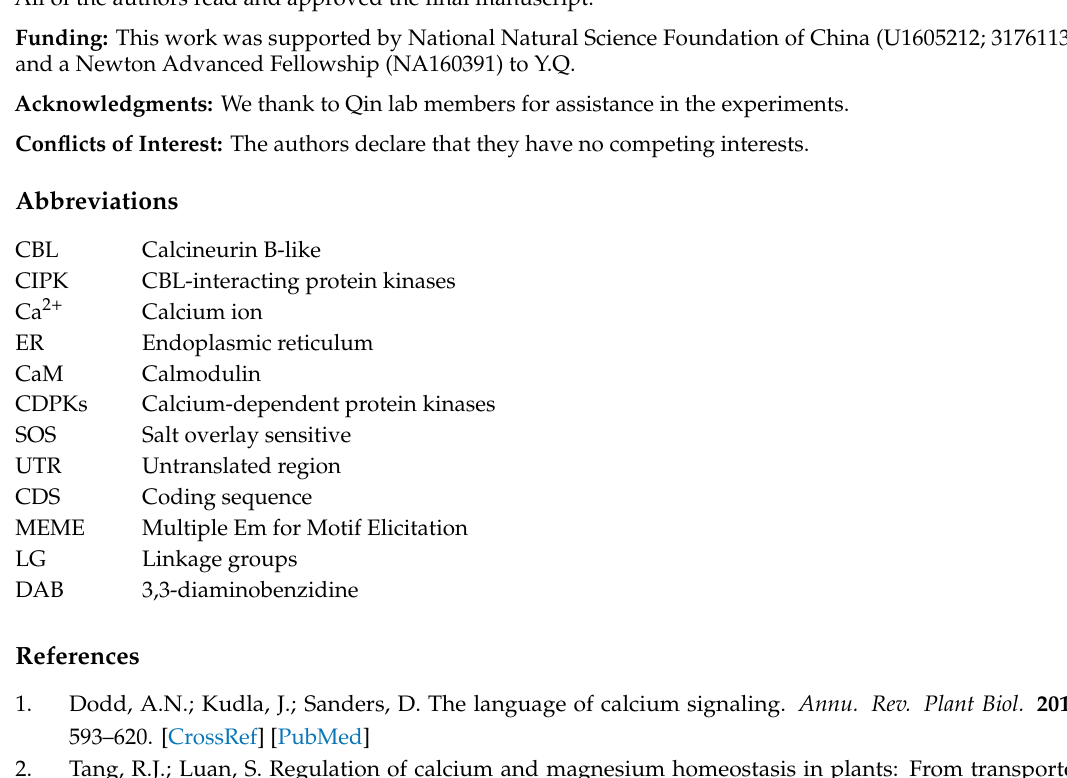
Figure S1: The distribution of conserved motifs in pineapple CBL proteins, Figure S2: The distribution of conserved motifs in pineapple CIPK proteins, Table S3: List of primers used in present